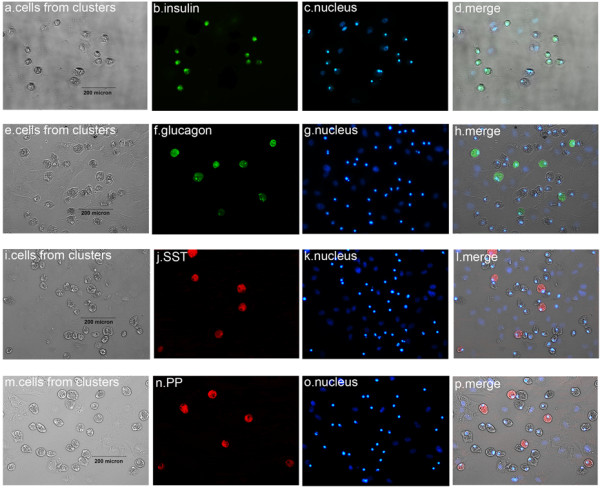
Immunofluorescence assay of single cells from islet-like cell clusters. On enzymatic dispersion and reculture in lysine-coated plastic dishes, the single cells from islet-like cell clusters adhered and expressed insulin (A), (B), (C), (D), glucagon (E), (F), (G), (H), SST (I), (J), (K), (L) and PP (M), (N), (O), (P) respectively.